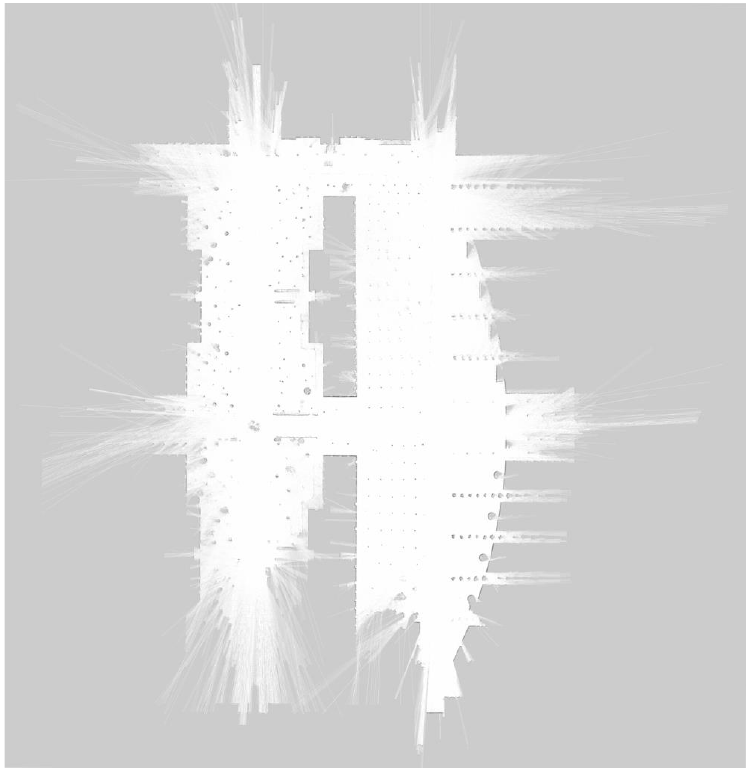
Figure 11. Grid map obtained in the pre-execution phase (Figure 2), and latter used in the execution phase (Figure 3). We generated this map using datasets previously recorded during the experimental sessions described in